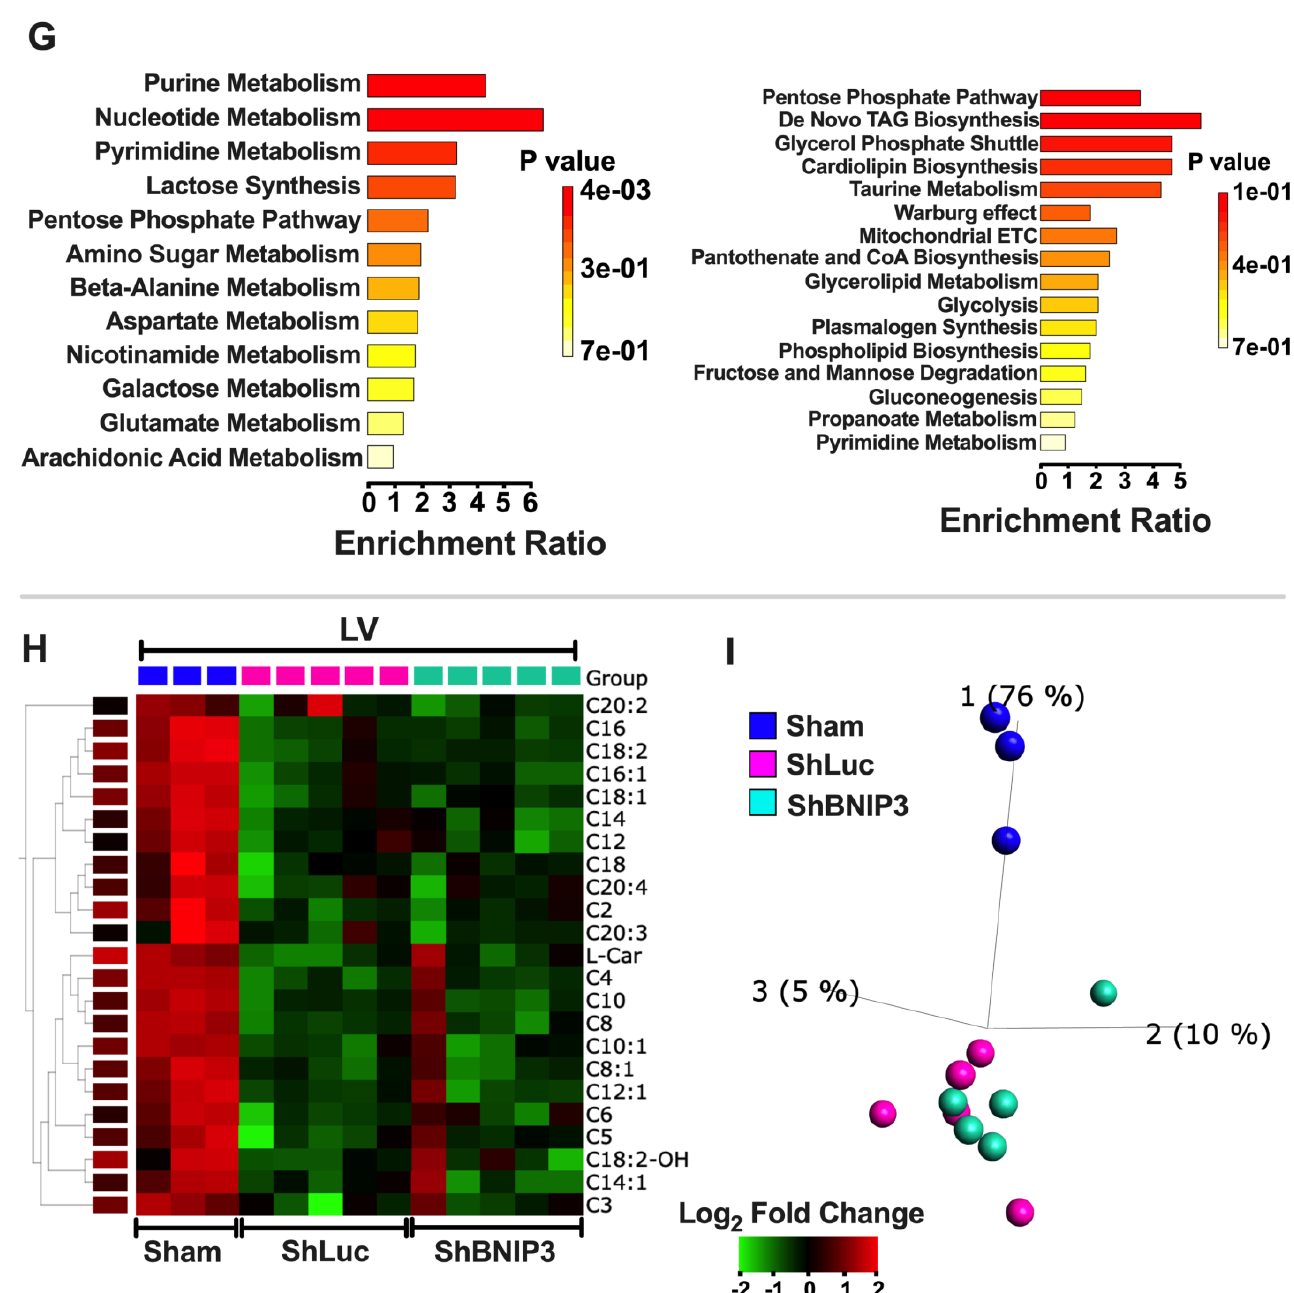
Figure 4. Visualization and validation of the differentially expressed metabolites in ShBNIP3 vs. ShLuc groups in the LV myocardium untargeted metabolomic dataset. ( A ). Venn diagrams show the number of metabolites that were differentially abundant in ShLuc vs. Sham (red), ShBNIP3 vs. Sham (green), and ShBNIP3 vs. ShLuc (blue). ( B , C ). Heat maps and PCA plots show the relative log 2 -fold expression and the variance in biological samples, respectively, in Sham, ShLuc, and ShBNIP3 groups of the differentially abundant metabolites in ShBNIP3 vs. ShLuc groups. ( D ). Volcano plot shows the log 2 -fold change in group means for the metabolites whose abundance in- creased (red) or decreased (green) in the ShBNIP3 vs. ShLuc groups, taking a cutoff −Log 10 p -value of 1.3 ( p < 0.05). ( E ). Heat maps show the most enriched Metabolic Pathways by the −Log 10 p -value of the untargeted metabolomics dataset. The heat maps were generated in IPA after “ Core Analyses ” of each of the two-group comparisons, which were then compared with each other in IPA’s “ Comparison Analyses ” function. ( F ). Metabolic pathways that were predicted to be enhanced (orange bar) or attenuated (blue bar) in shBNIP3 vs. ShLuc, taking a cutoff − Log 10 p -value of 1.3